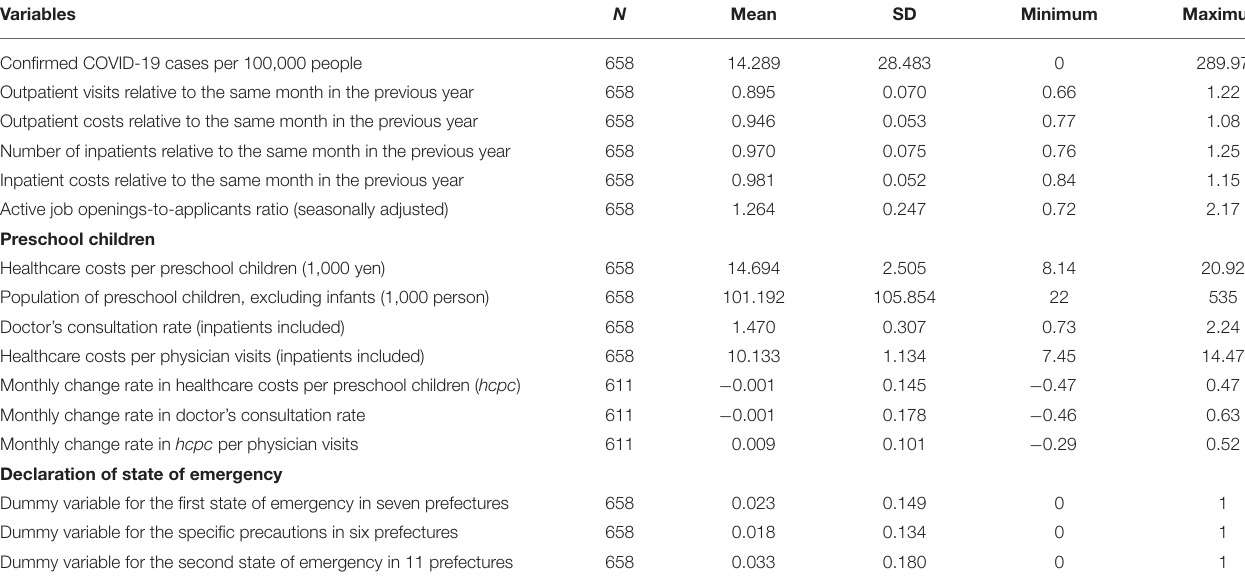
TABLE 1 | Monthly summary statistics by prefecture.